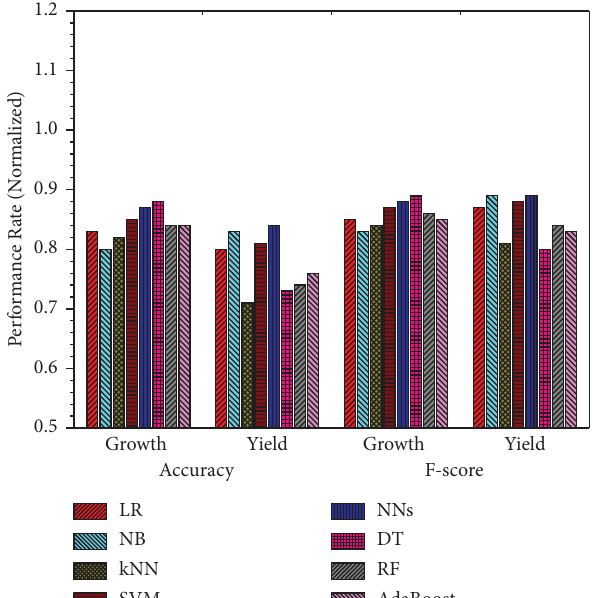
Figure 3: Comparison of the proposed model AdaBoost for classifcation performance in terms of accuracy and F 1 score of various ML algorithms on the basis of growth and yield metrics, considering the combined efect of all water quality parameters.